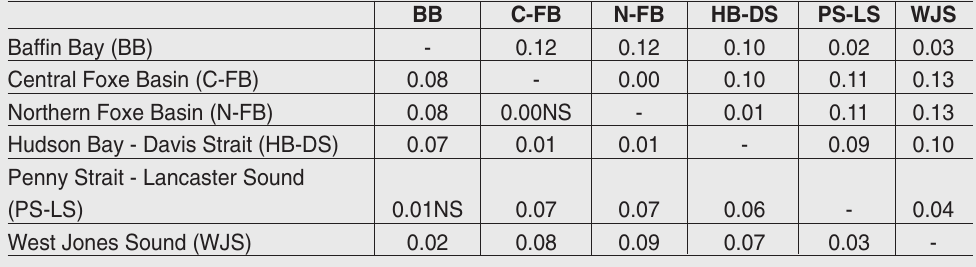
Table 4. Genetic distances between walrus stocks. Below the diagonal are FST values with insignificant values denoted by NS. (corrected for multiple tests p=0.003). Above the diagonal is Nei’s DS.